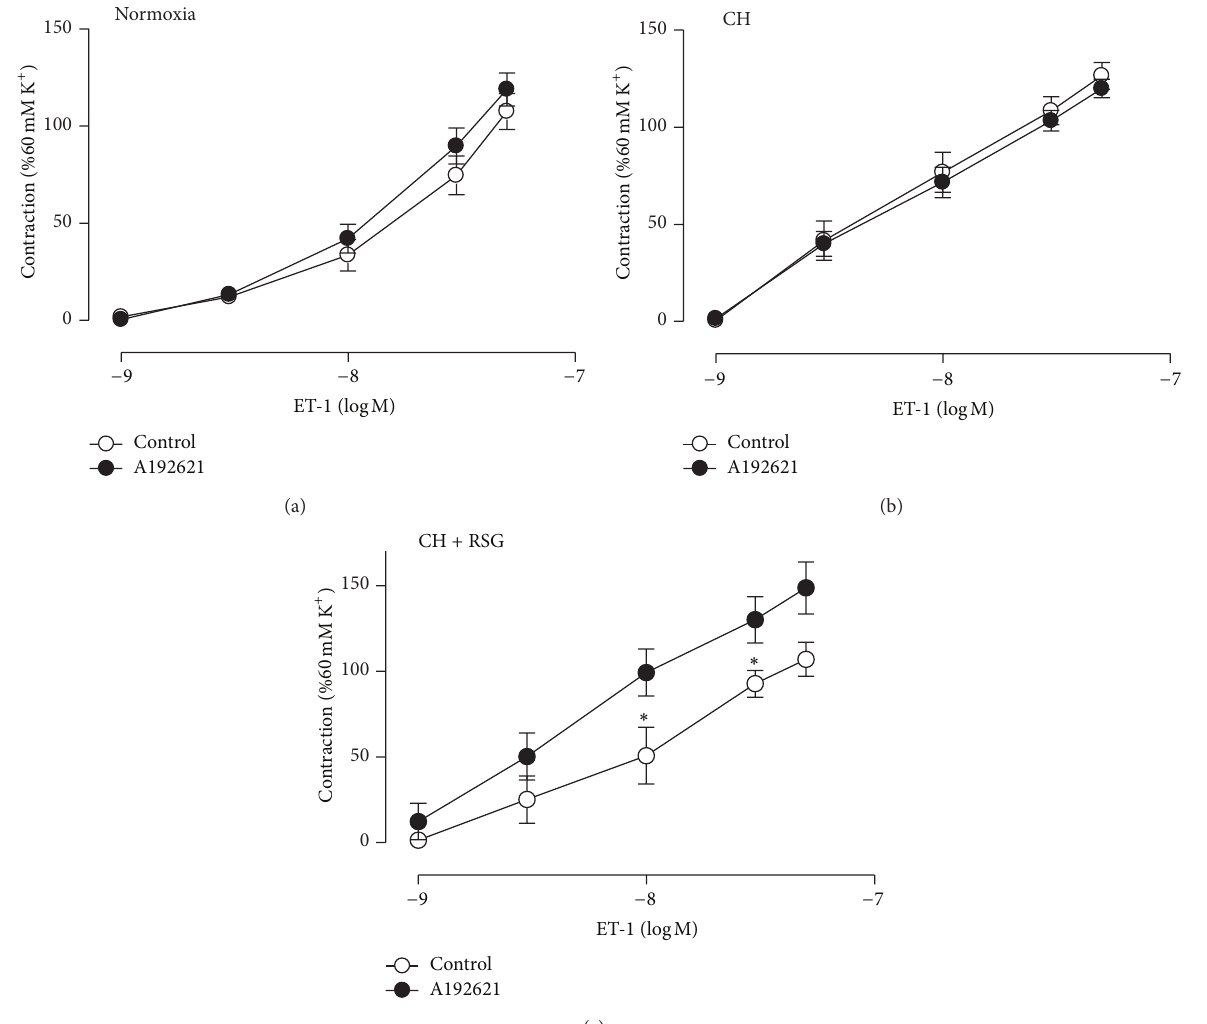
Figure 4: The ameliorative effect of RSG on ET-1-induced contractions was abrogated by ET R antagonist A192621 (10nmol/L) in pulmonary arteries from normoxia- (a), CH (b), or RSG-treated contractions to ET-1 pretreated with ET B CH (c) rats. Data were mean ± SEM from 5 to 8 rats. ∗ 𝑃 < 0.05 versus